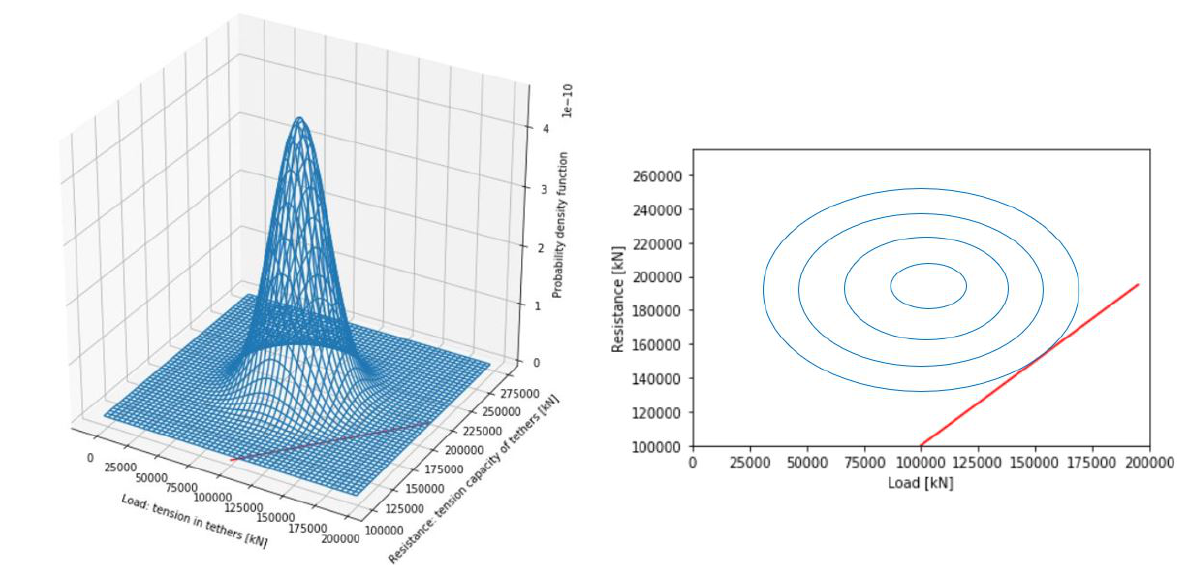
Figure 5. Joint probability density function (left) and contour plot (right) for yielding Parameter Distr. 2 Mean St.dev. CV Source